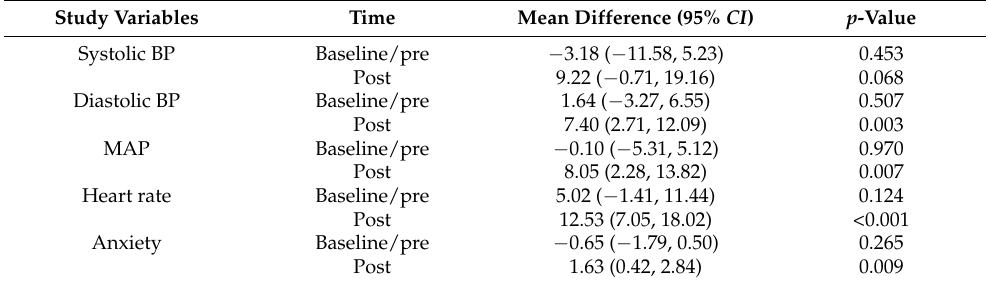
Table 2. Mean difference of study variables between control and experimental groups based on time.